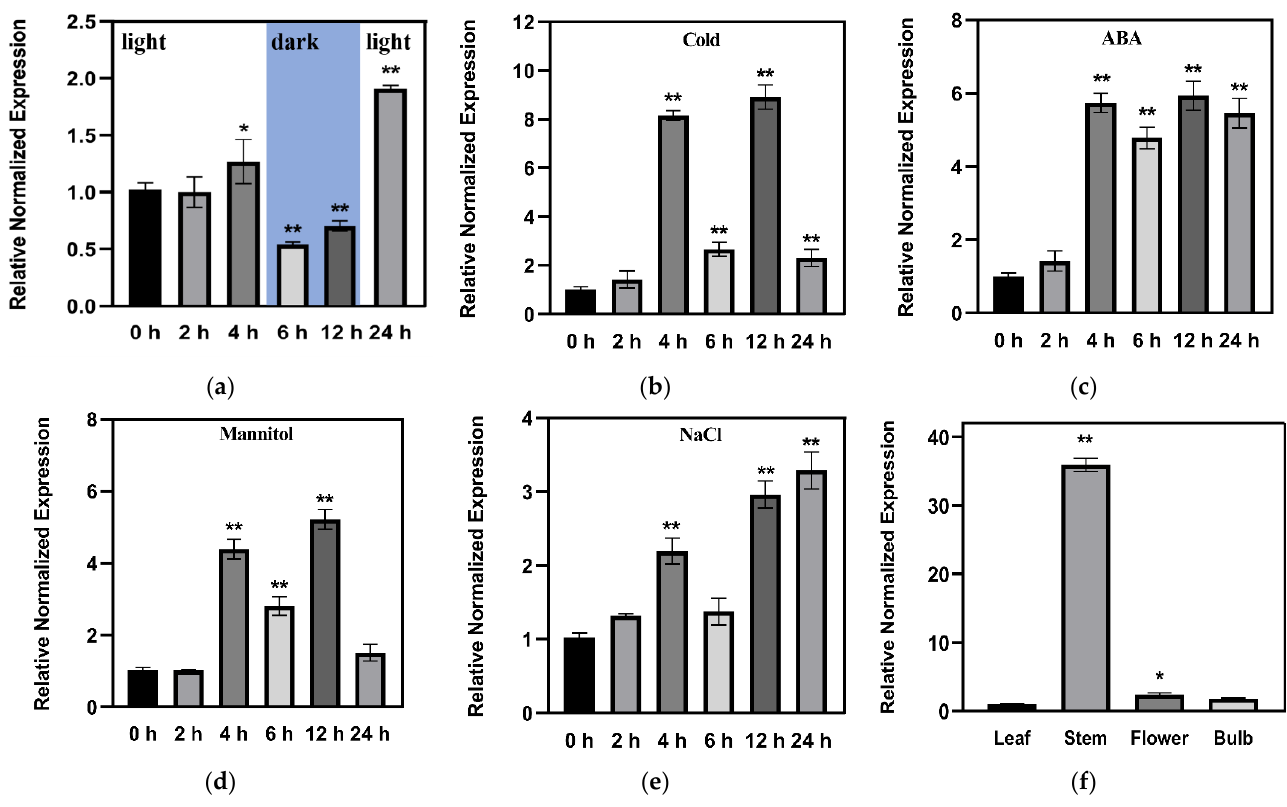
Figure 3. Expression patterns of LoSWEET14 in leaves under stress treatments and in different tissues. Eight-week-old lily seedlings were untreated, ( a ) were treated with 4 °C ( b ), 150 µM ABA ( c ), 200 mM mannitol ( d ), and 200 mM NaCl ( e ) for 24 h, respectively. Tissue-specific expression analyses were conducted in the leaf, stem, bulb, and flower ( f ). The seedings were under a 14 h light and 10 h dark (from 5 h to 15 h) photoperiod. Each value indicates Mean ± SE (standard error). Asterisks indicate a significant difference ** p < 0.01 and * p < 0.05 compared with the corresponding controls.